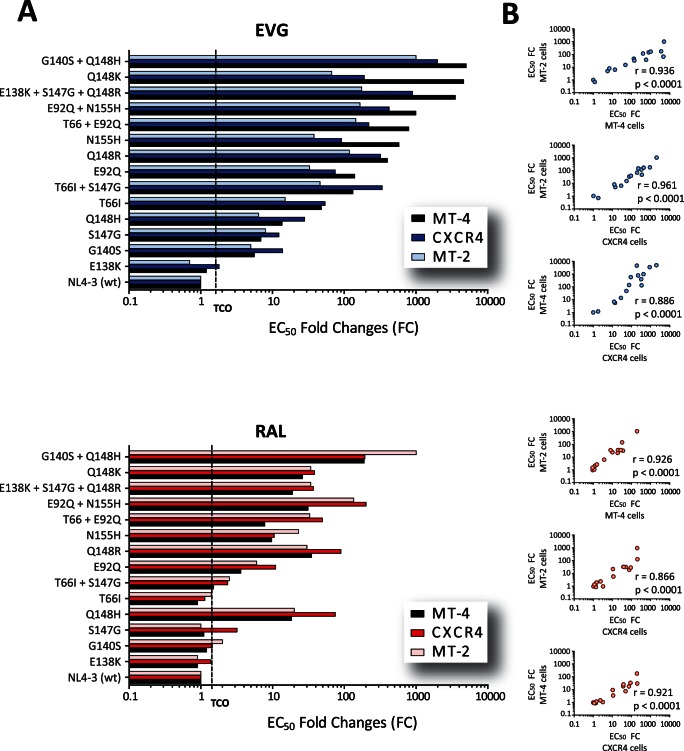
Susceptibility to EVG and RAL of 14 p2-INT-recombinant viruses carrying mutations associated with resistance to INSTIs.(A) Drug susceptibility evaluated by measuring luciferase expression in triplicate in MT-4 cells (VIRALARTS™HIV) and CXCR4 cells, and cell viability in MT-2 cells. Technical cut-off (TCO) values for EVG (1.62-fold) and RAL (1.42-fold) were calculated by repeatedly testing the reference HIV-1NL4-3 strain using VIRALARTS™HIV. (B) Pearson correlation coefficient was used to determine the strength of association between the EC50 fold changes calculated using the three drug susceptibility assays. r, correlation coefficient and p, two-tailed p value.